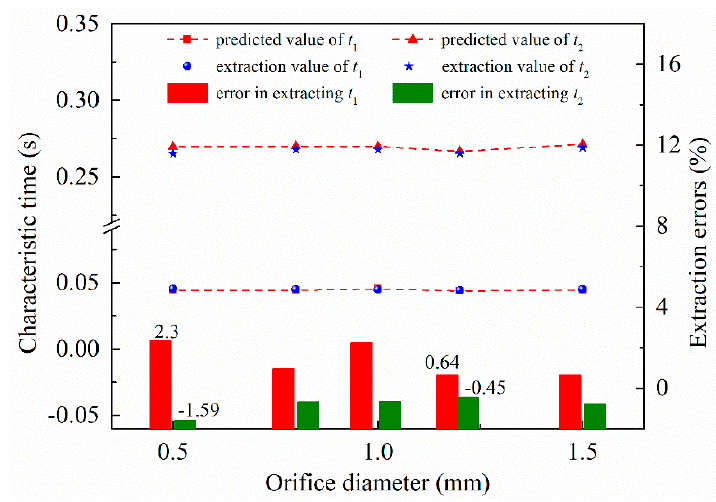
Figure 17. Predicted values, extraction values, and extraction errors of t 1 and t 2 for different orifice diameters.